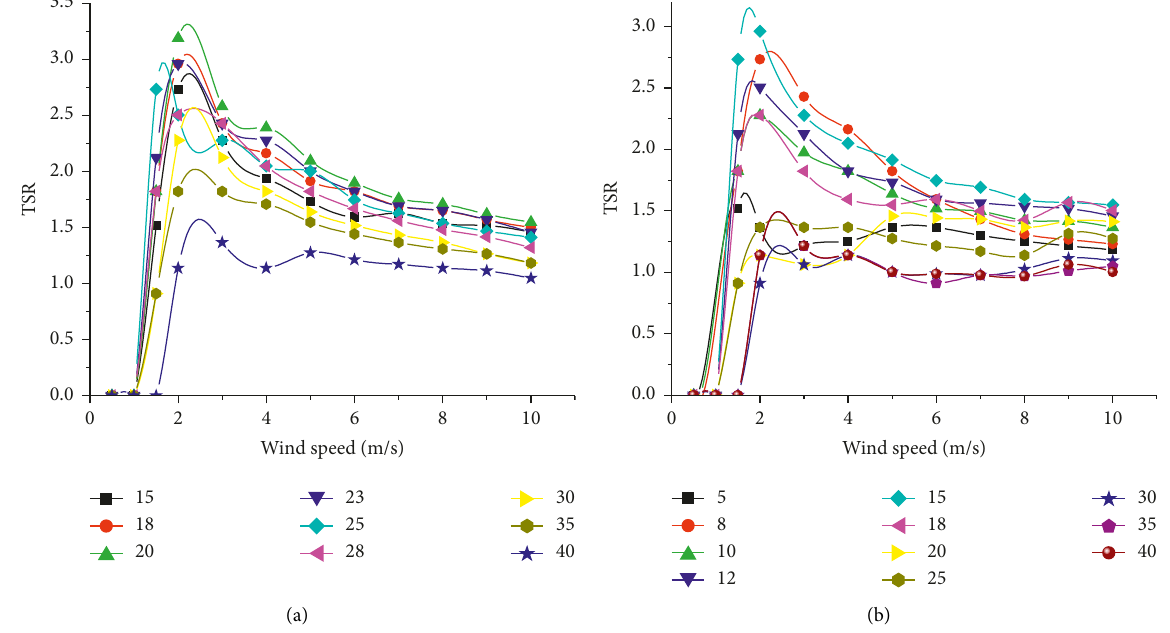
Figure 9: (a) TSR versus wind speeds for Styrofoam and (b) aluminium blades, Figure 11(a), C of 0.431 translated to a maximum ex- p